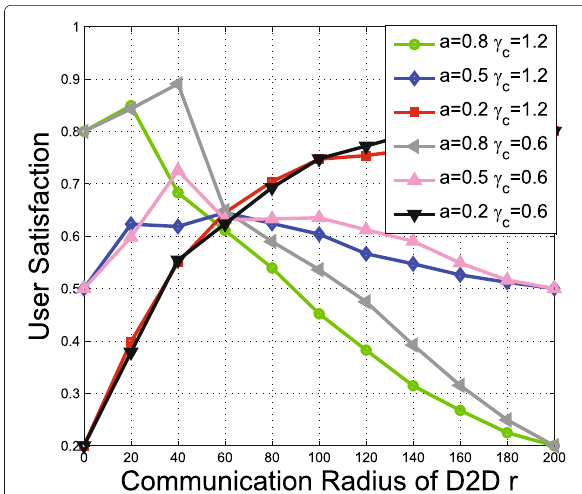
Fig. 13 The relationship between user satisfaction and D2D communication radius with γ c = 1 and a = 0.8. This figure also illustrates the effect of system outage probability and user transmission rate on user satisfaction with different